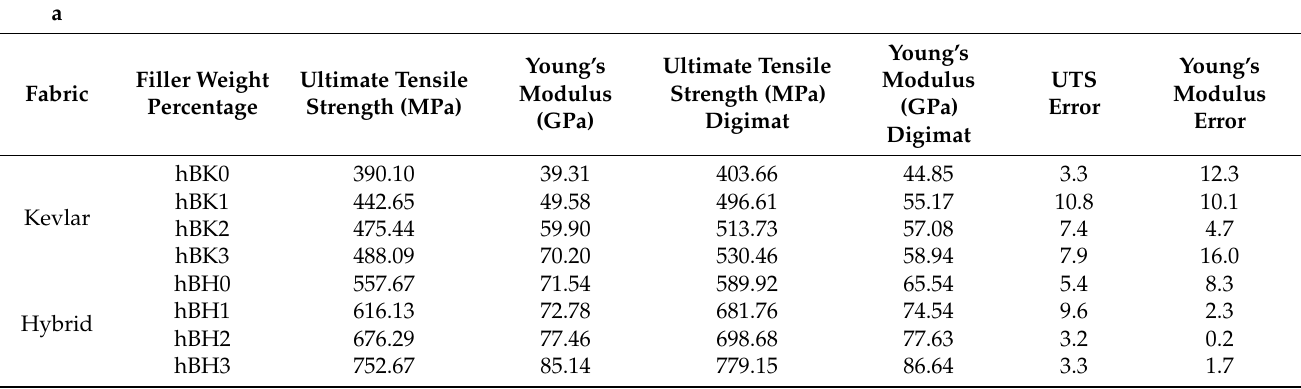
Table 5. ( a ). Tensile values of hBN-filled composites. ( b ) Tensile values of graphene-filled